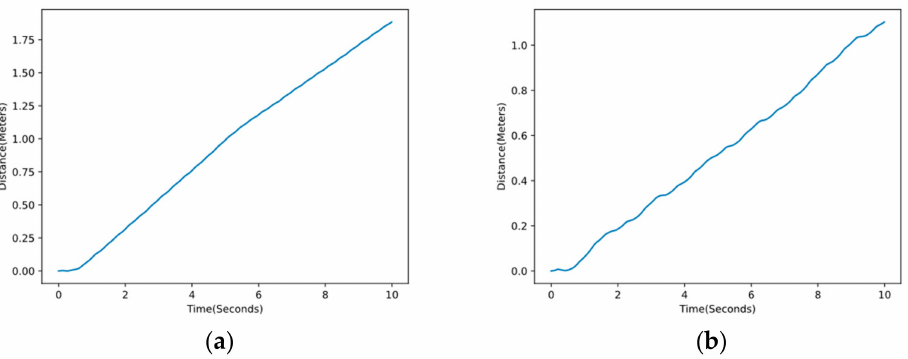
Figure 17. Picture showing the distance the center of gravity has moved. ( a ) The distance the center of gravity has moved on the 5 ◦ slope. ( b ) The distance the center of gravity has moved on the 11 ◦